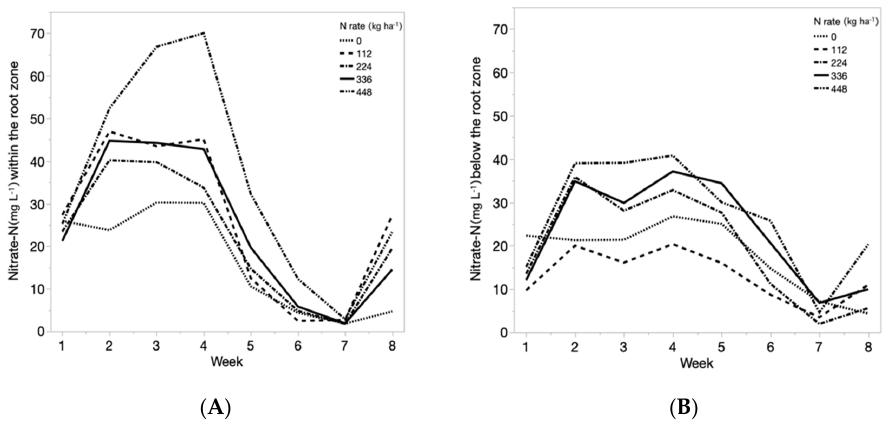
Figure 3. The concentration of NO 3 -N ( A ) within the root zone (30 cm) and ( B ) below the root zone (60 cm) at Waimānalo during the study period for the application N rates of meat and bone meal.